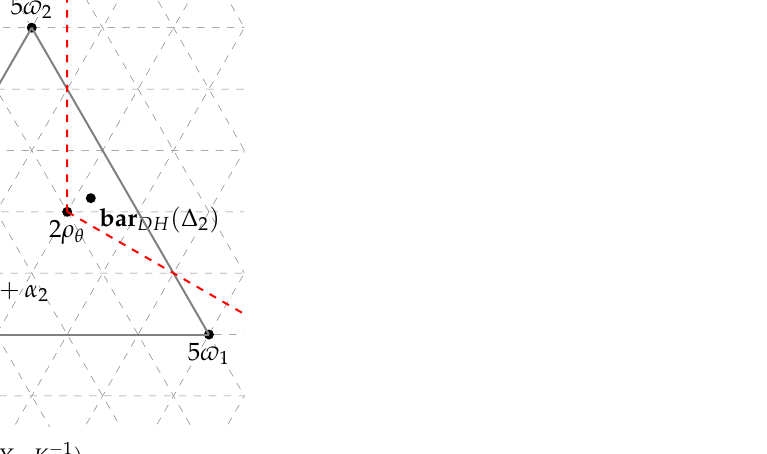
Figure 2. ∆ 2 = ∆ ( X 2 , K − 1